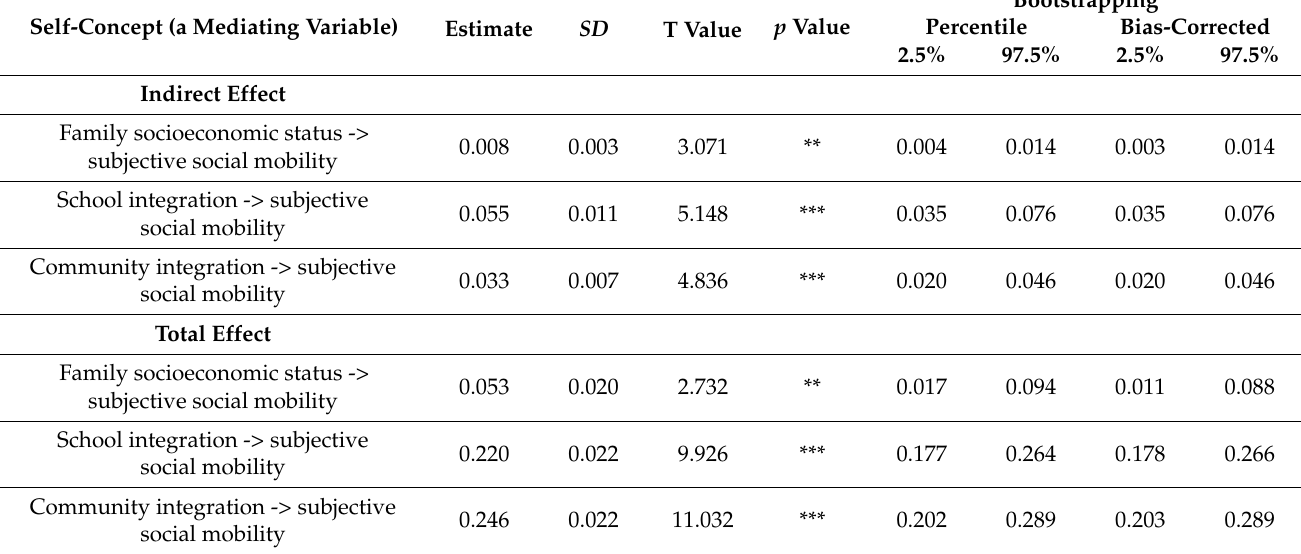
Table 6. Mediating and total effects.